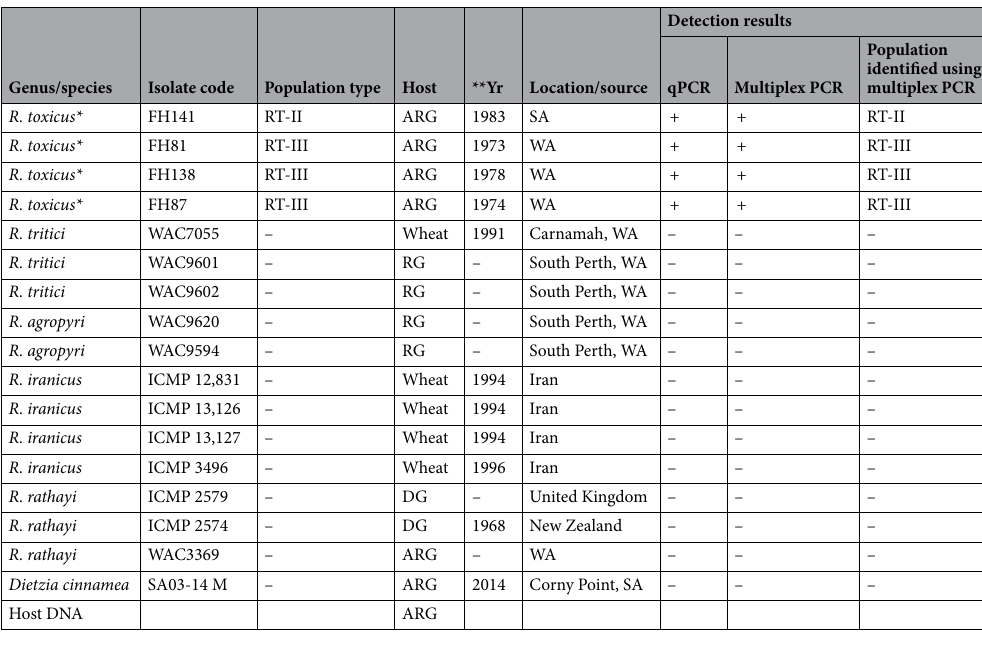
Table 1. Composition of inclusivity and exclusivity panels to confirm specificity of multiplex endpoint PCR and TaqMan qPCR to detect and discriminate Rathayibacter toxicus. *Only DNA was available for this study; AIC artificial internal control; **Yr—year of collection.